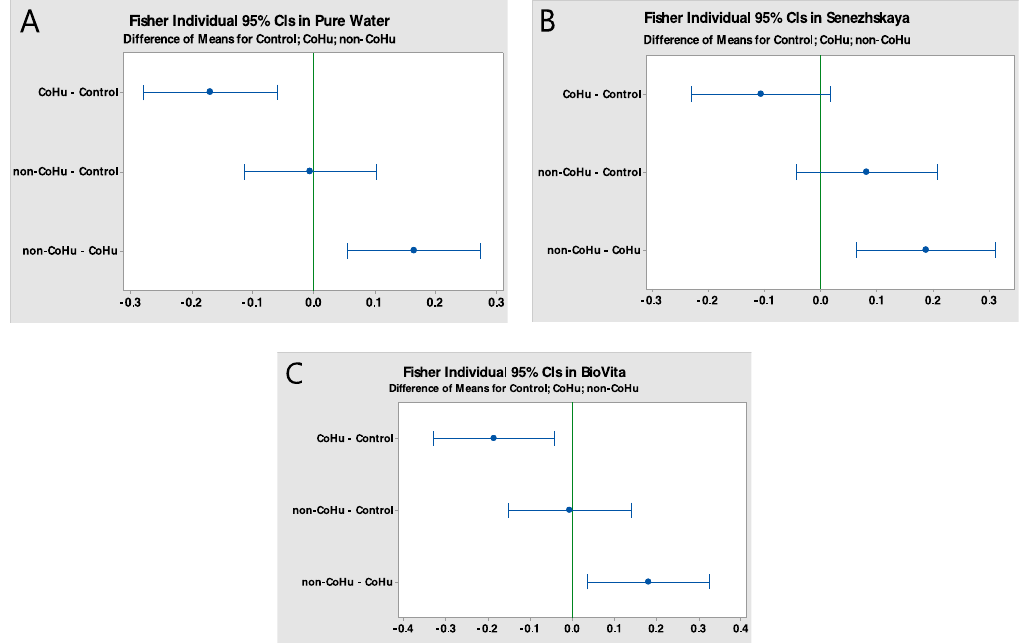
Figure 3. Fisher pairwise comparisons for surface tension measurements in pure water ( A ), Senezhskaya ( B ) and BioVita ( C ) mineral waters, where CIs are confidence intervals. If an interval does not contain zero, the corresponding means are significantly different.